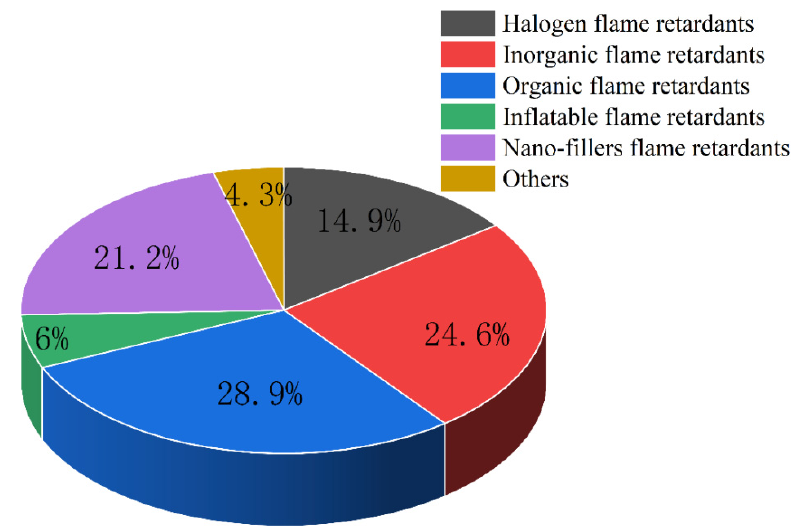
Figure 2. The proportion of representation of each flame-retardant polymer material.